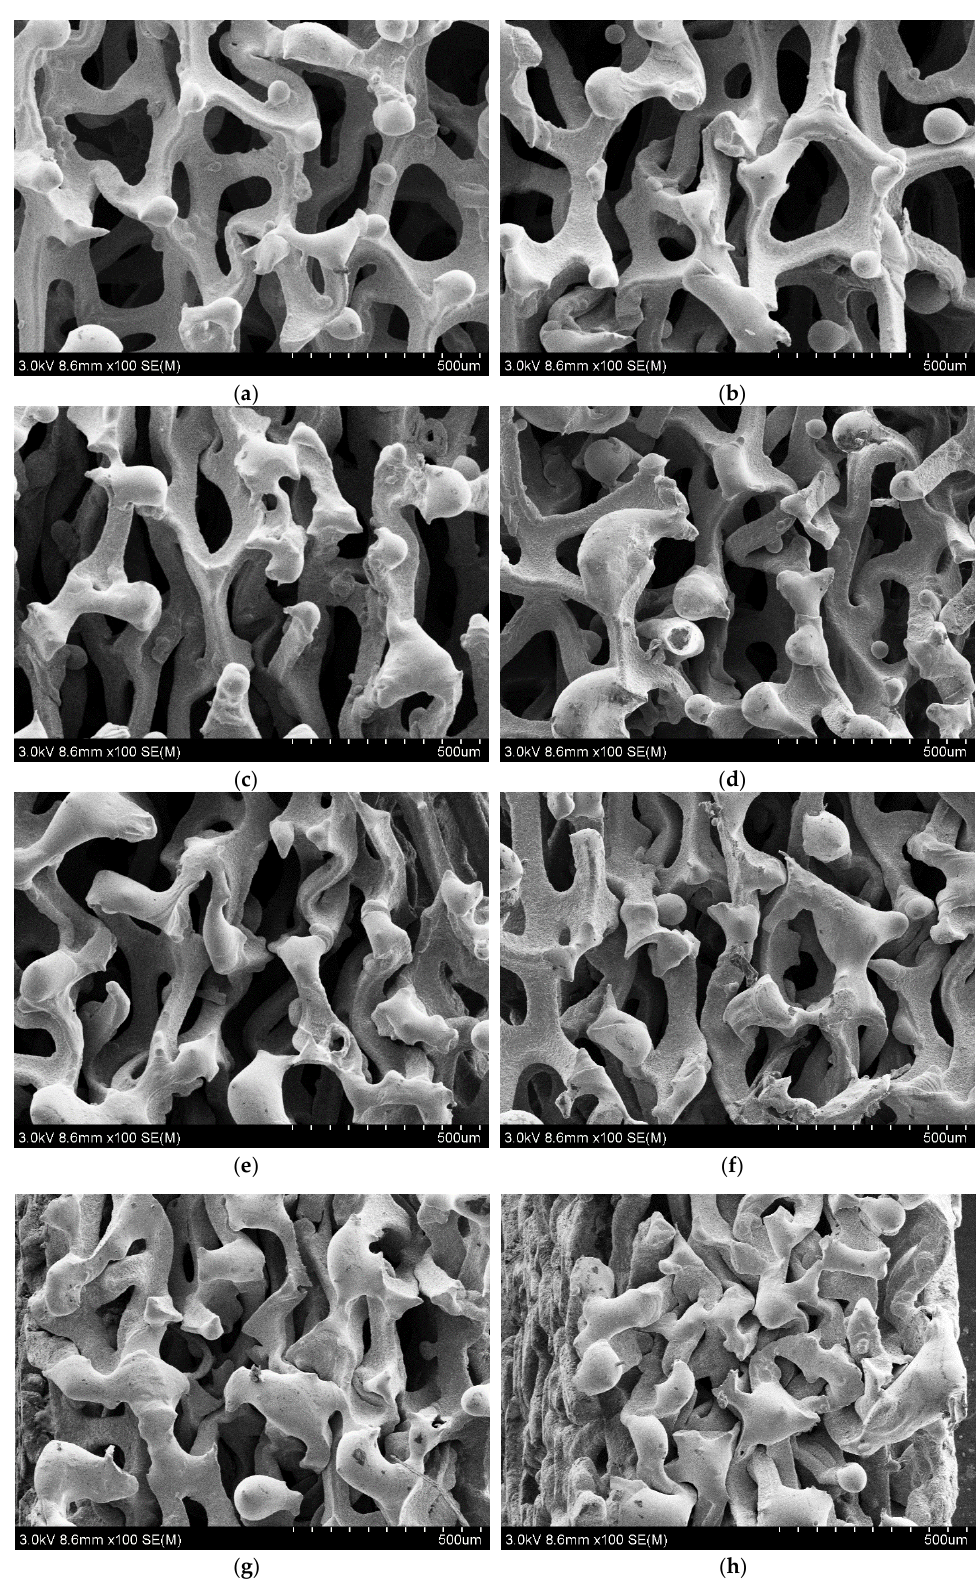
Figure 9. Detailed section morphologies of the compressed samples by SEM with high magnification. ( a ) 10%; ( b ) 20%; ( c ) 30%; ( d ) 40%; ( e ) 50%; ( f ) 60%; ( g ) 70%; ( h ) 80%.